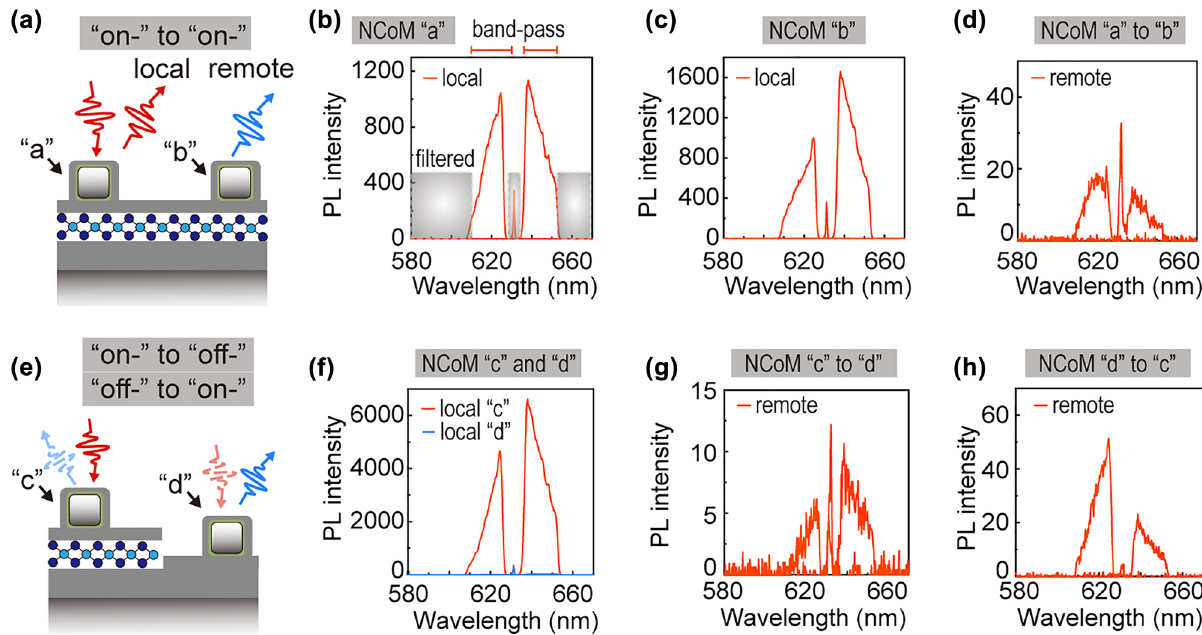
SEF realized by NCoM pairs. (a–d) show the local (b, c) and remote (d) PL spectra of the NCoM pair whose receiving Figure 4: Remote WS 2 , schematic in (a). (e–h) Show the local (f) and remote (g, h) PL spectra of the NCoM pair whose and transmitting antennas were all on WS 2 , schematic in (e). Schematics are not to scale. receiving or transmitting antenna was off WS 2